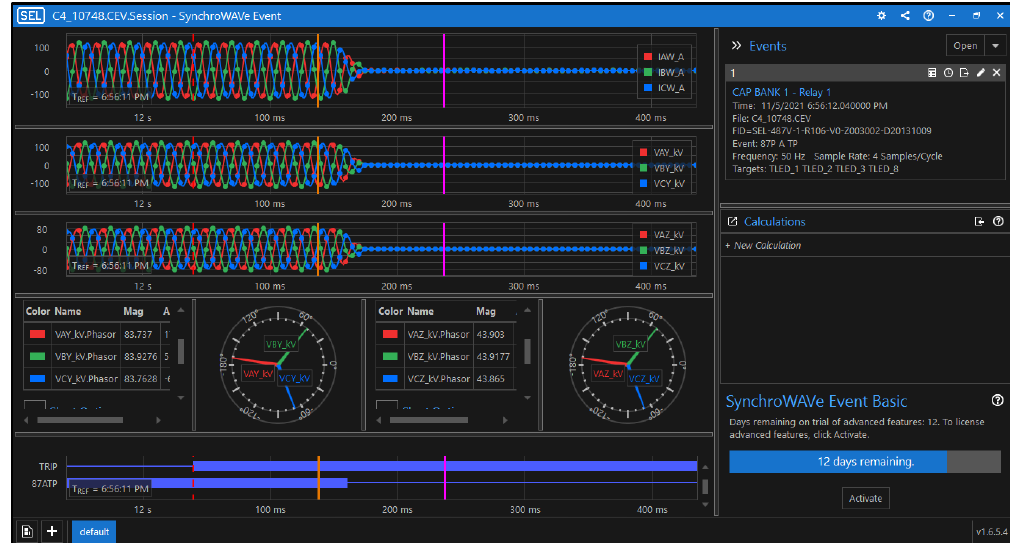
Figure 5. SynchoWAVE Event simulation results for four-element failures below the tap. Table 3. A Summary of the results for four-element failures below the tap.